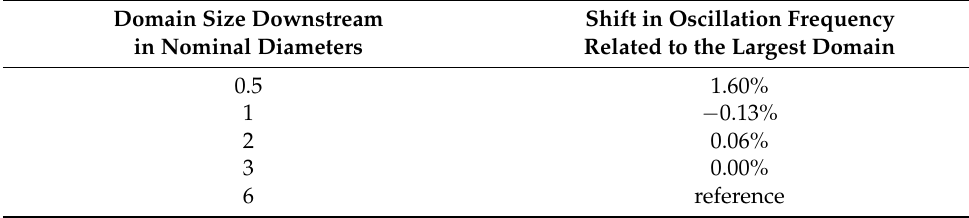
Table 3. Study of the required length of a straight outlet run.